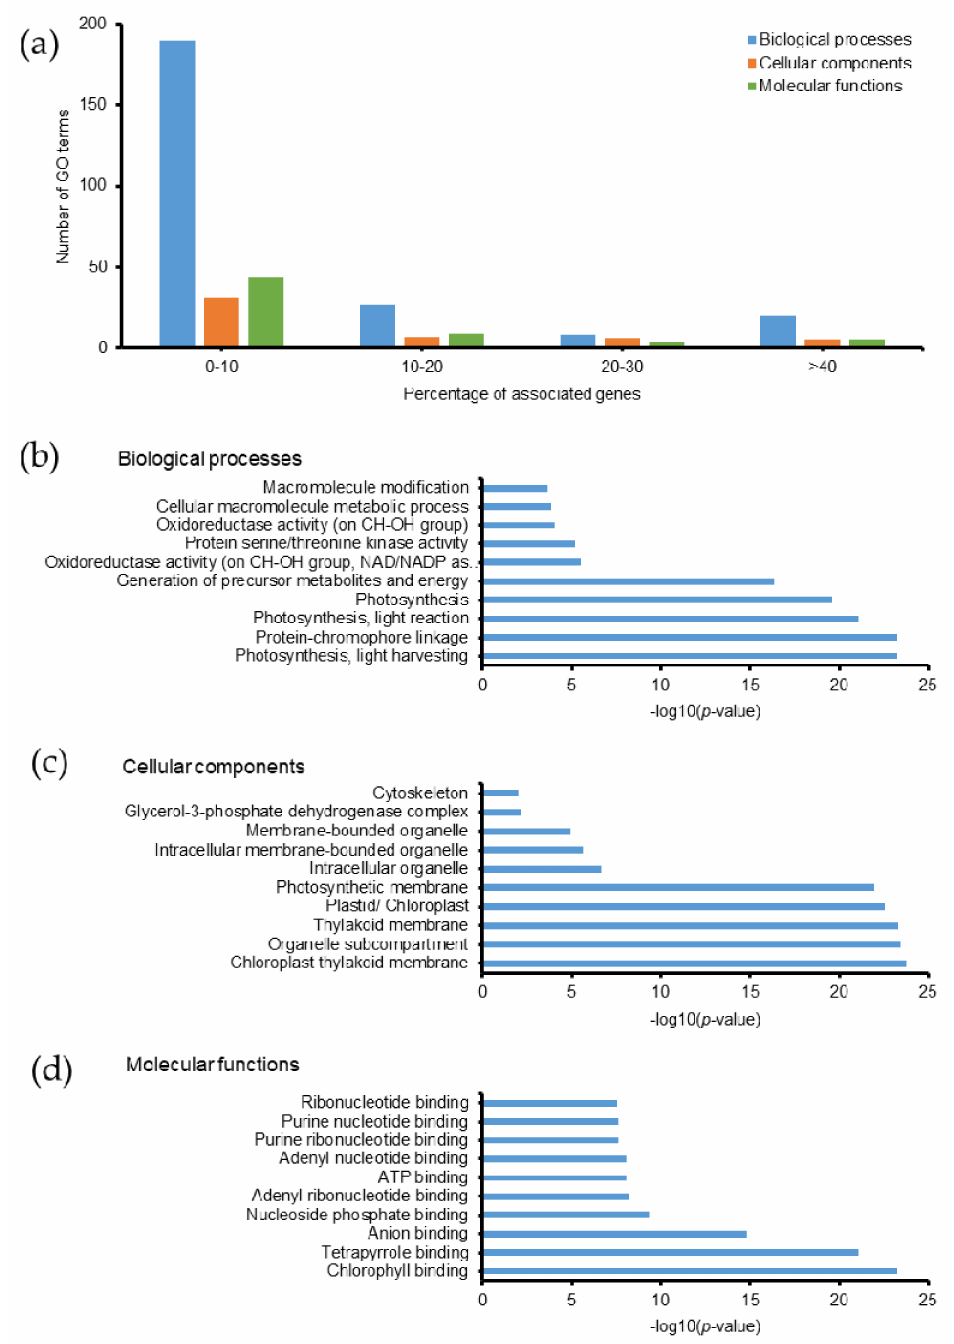
Figure 6. Gene ontology of persulfidated proteins in Emiliania huxleyi using ClueGO. ( a ) Summary of the number of GO terms according to percentage associated genes. Top 10 ( b ) biological processes, ( c ) cellular components, and ( d ) molecular functions based on − log( p